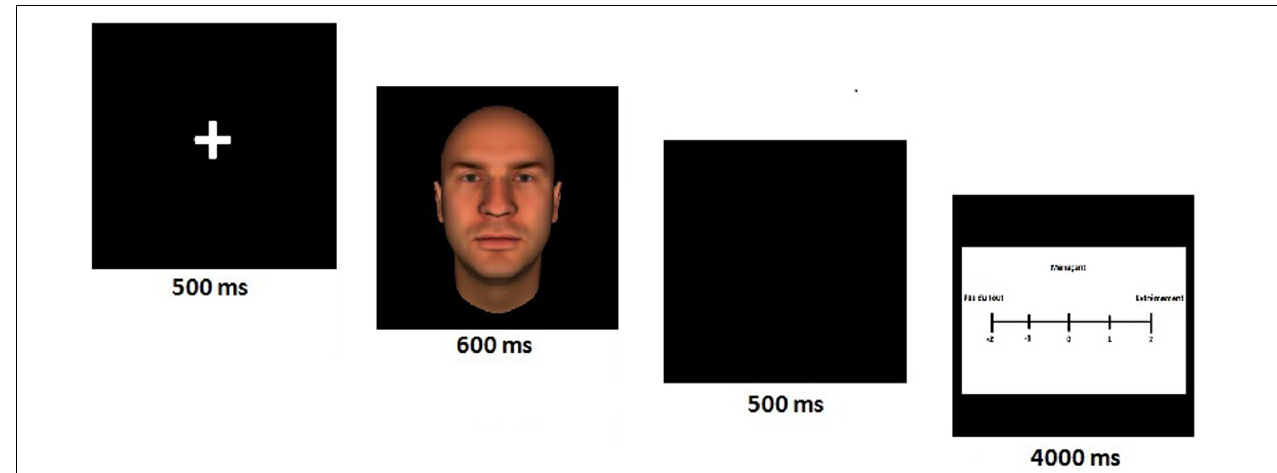
FIGURE 1 | The evaluation task of avatars’ faces. The task required participants to attribute a value as to how dominant/trustworthy the avatar was, on a scale from -2 to + 2. This paradigm was adapted for